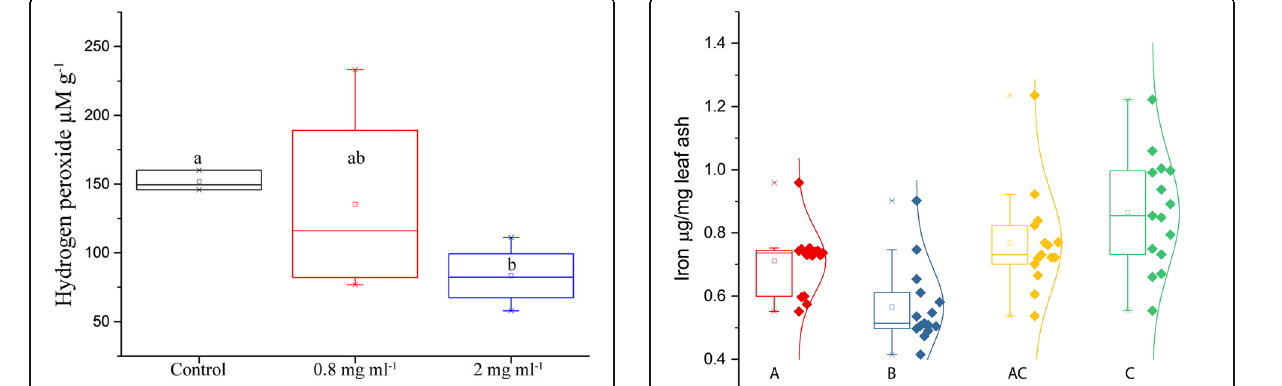
Fig. 5 Amount of soluble hydrogen peroxide per gram of leaf tissue from oilseed rape treated with nutrient solution containing IONs and challenged with drought for 5 days ( n = 16, p value = 0.004)